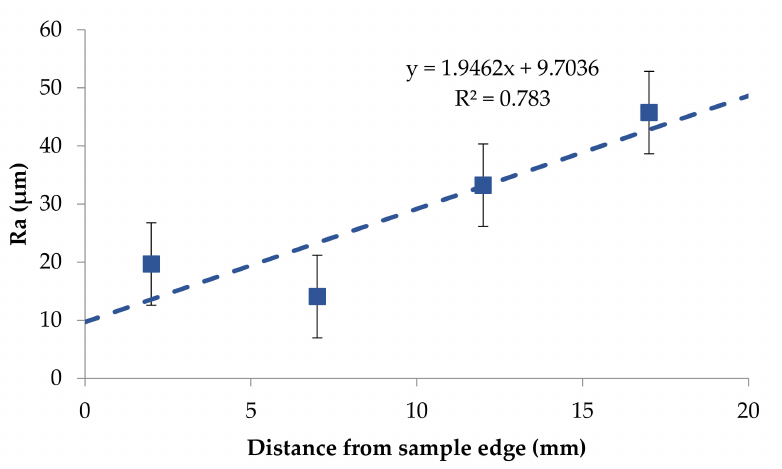
Figure 19. The relationship between the roughness average R a and the distance on the edge 1 on the briquette front surface—top to bottom direction.